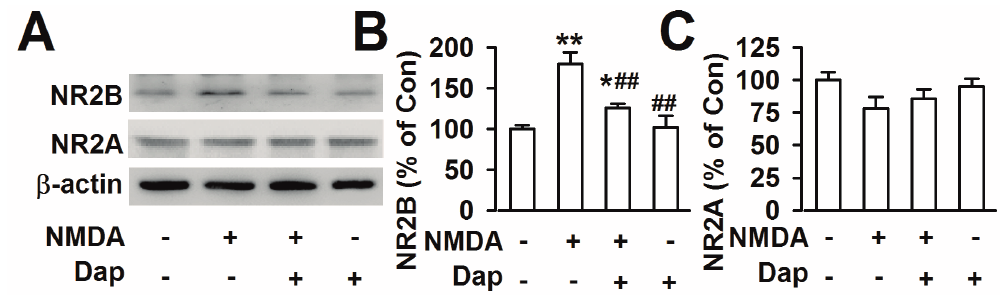
Figure 4. Effects of Dap on the NMDA receptors ( A ) Expression levels of NR2A and NR2B proteins were detected by western blot. ( B ) The result showed that the levels of NR2B markedly increased after exposure to NMDA in cultured cortical neurons. Pretreatment of 10 μ M Dap significantly prevented the increase of NR2B by NMDA